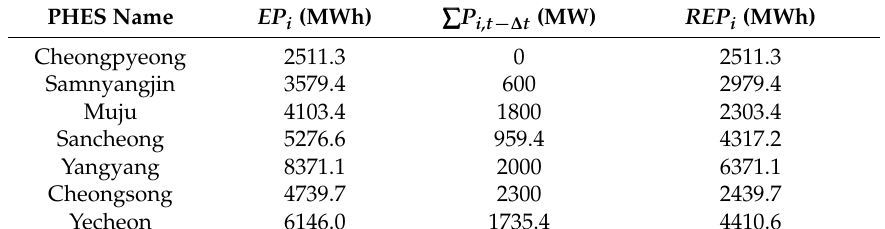
Table 6. EP i and P i,t − ∆ t on the peak-load day in 2029.